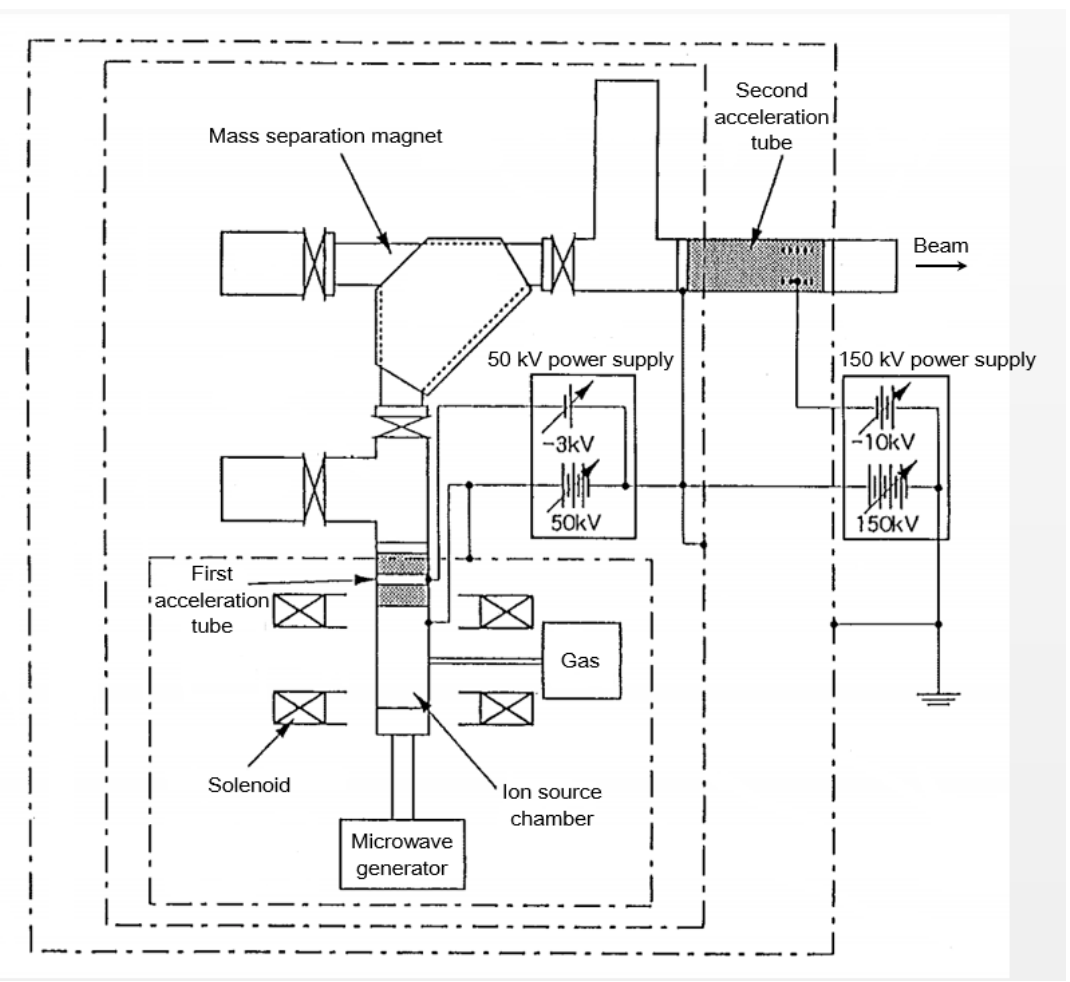
Figure 4. The schematic diagram of 200 kV ion-implanter at WERC.